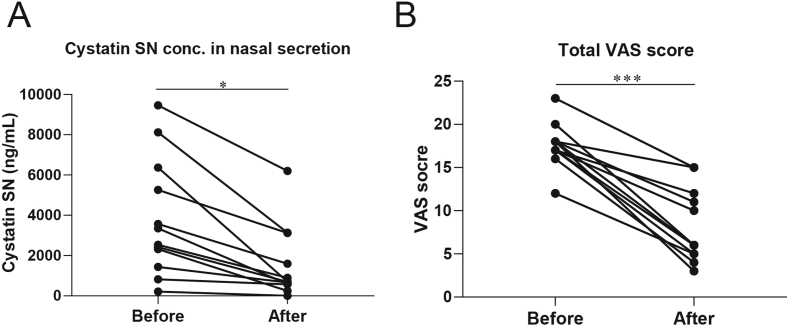
Comparison of Cystatin SN (A) and VAS score (B) before and after the medical intervention (a combination of 2 sprays, 64 μg budesonide in the morning (1 spray per nostril; total, 128 μg per day) and 1 tablet of 10 mg montelukast). VAS, visual analogue scale. ∗∗∗: p < 0.001. ∗: p < 0.05